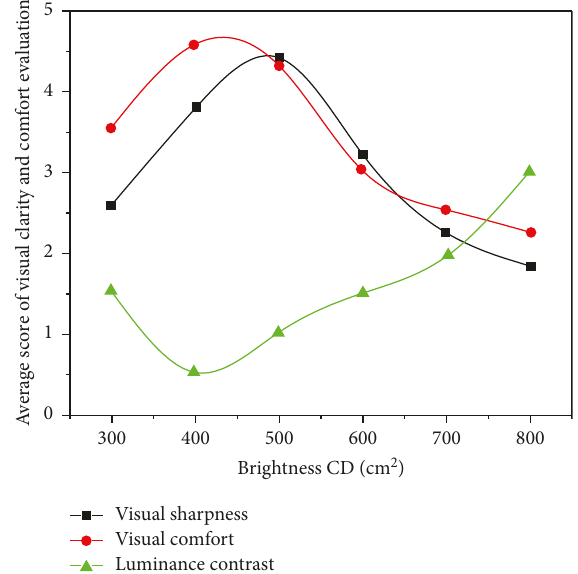
Figure 5: Comprehensive analysis diagram.